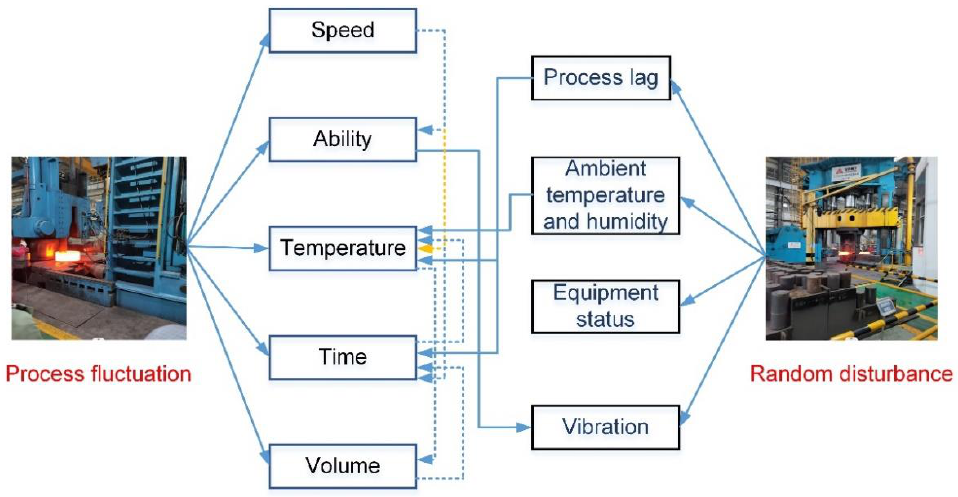
Figure 10. Category of disturbance factors for quality change in hot forming of forgings.